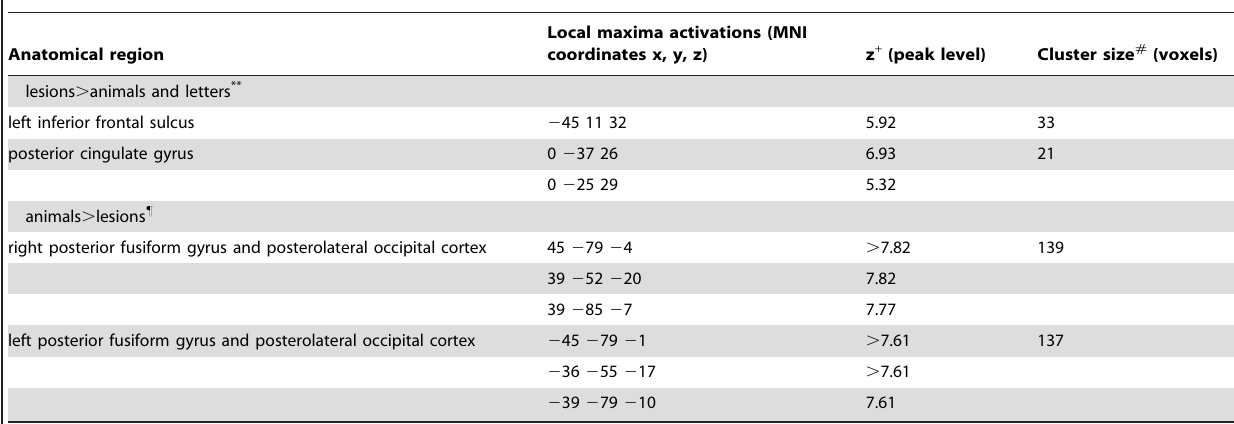
Table 2. Contrasts between diagnosing lesions and naming animals and letters *.